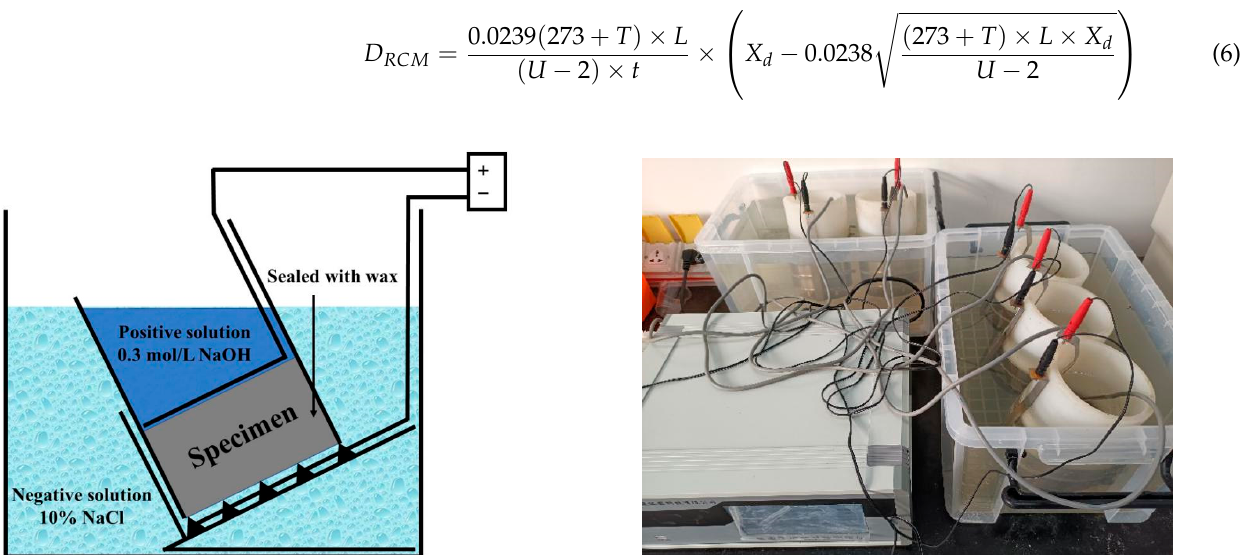
Figure 3. Schematic presentation and image of the RCM